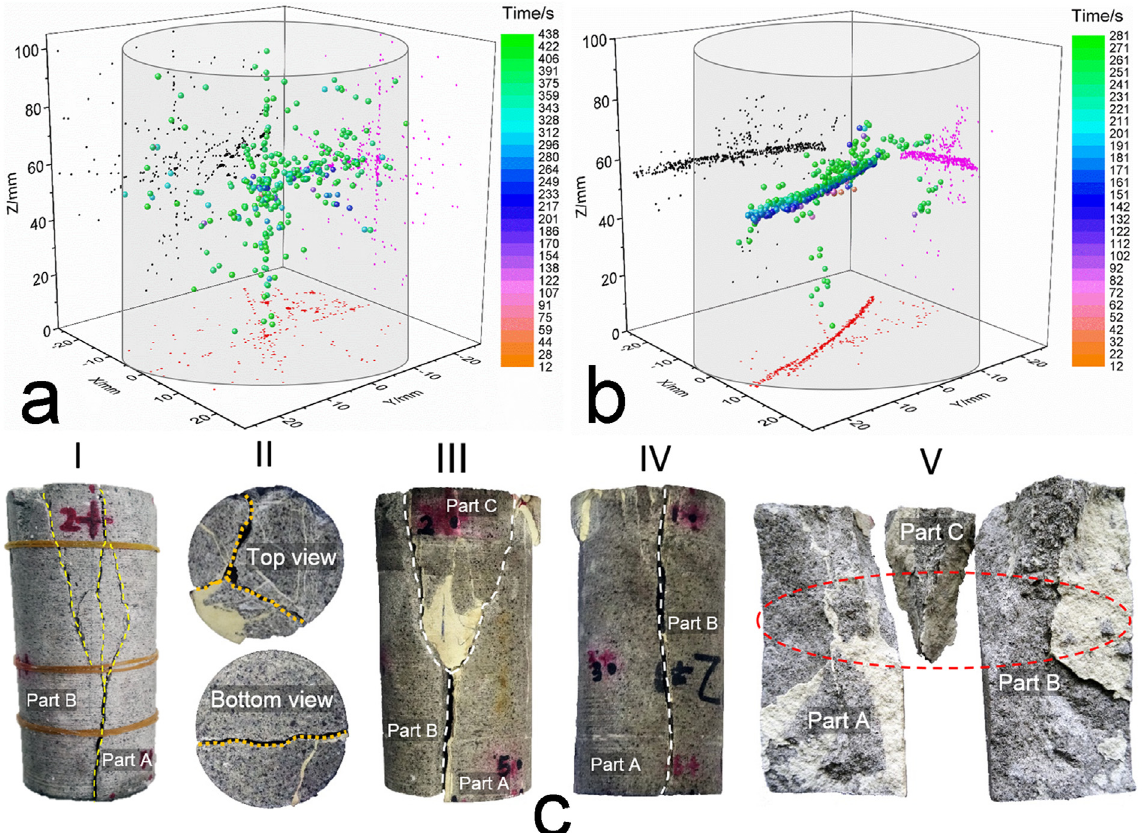
Fig 6. Damage source locations that were captured by an AE test. (a) Damage source distribution for the intact sandstone No. 1. (b) Damage source distribution for the restored sandstone No. 1. (c) Fracture modes of the intact sandstone and fractured sandstone (No. 1): I, Front view for the fracture mode of intact sandstone; II, Fracture mode for the ends, where the golden dashed line indicates the fracture form of the restored sandstone; III and IV, Front views for the fracture mode of the restored sandstone; V, Stripped parts from the fractured restored sandstone, where the red ellipse indicates the damage source concentration zone. The surface color changes between the intact sandstone and the restored sandstone are attributed mainly to the Vaseline painting to facilitate demolding during the restoration process.